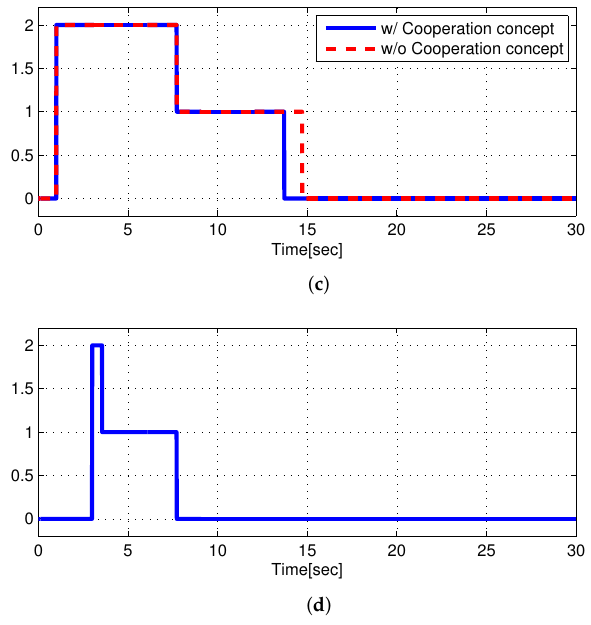
Figure 10. Simulation Results of case 2. ( a ) Lateral offset (to the center line of the original lane) of the ego vehicle. ( b ) Steering wheel angle of the ego vehicle. ( c ) Collision risk. 1: safe; 2: danger. ( d ) Cooperation index of method 2. 1: CD; 2: